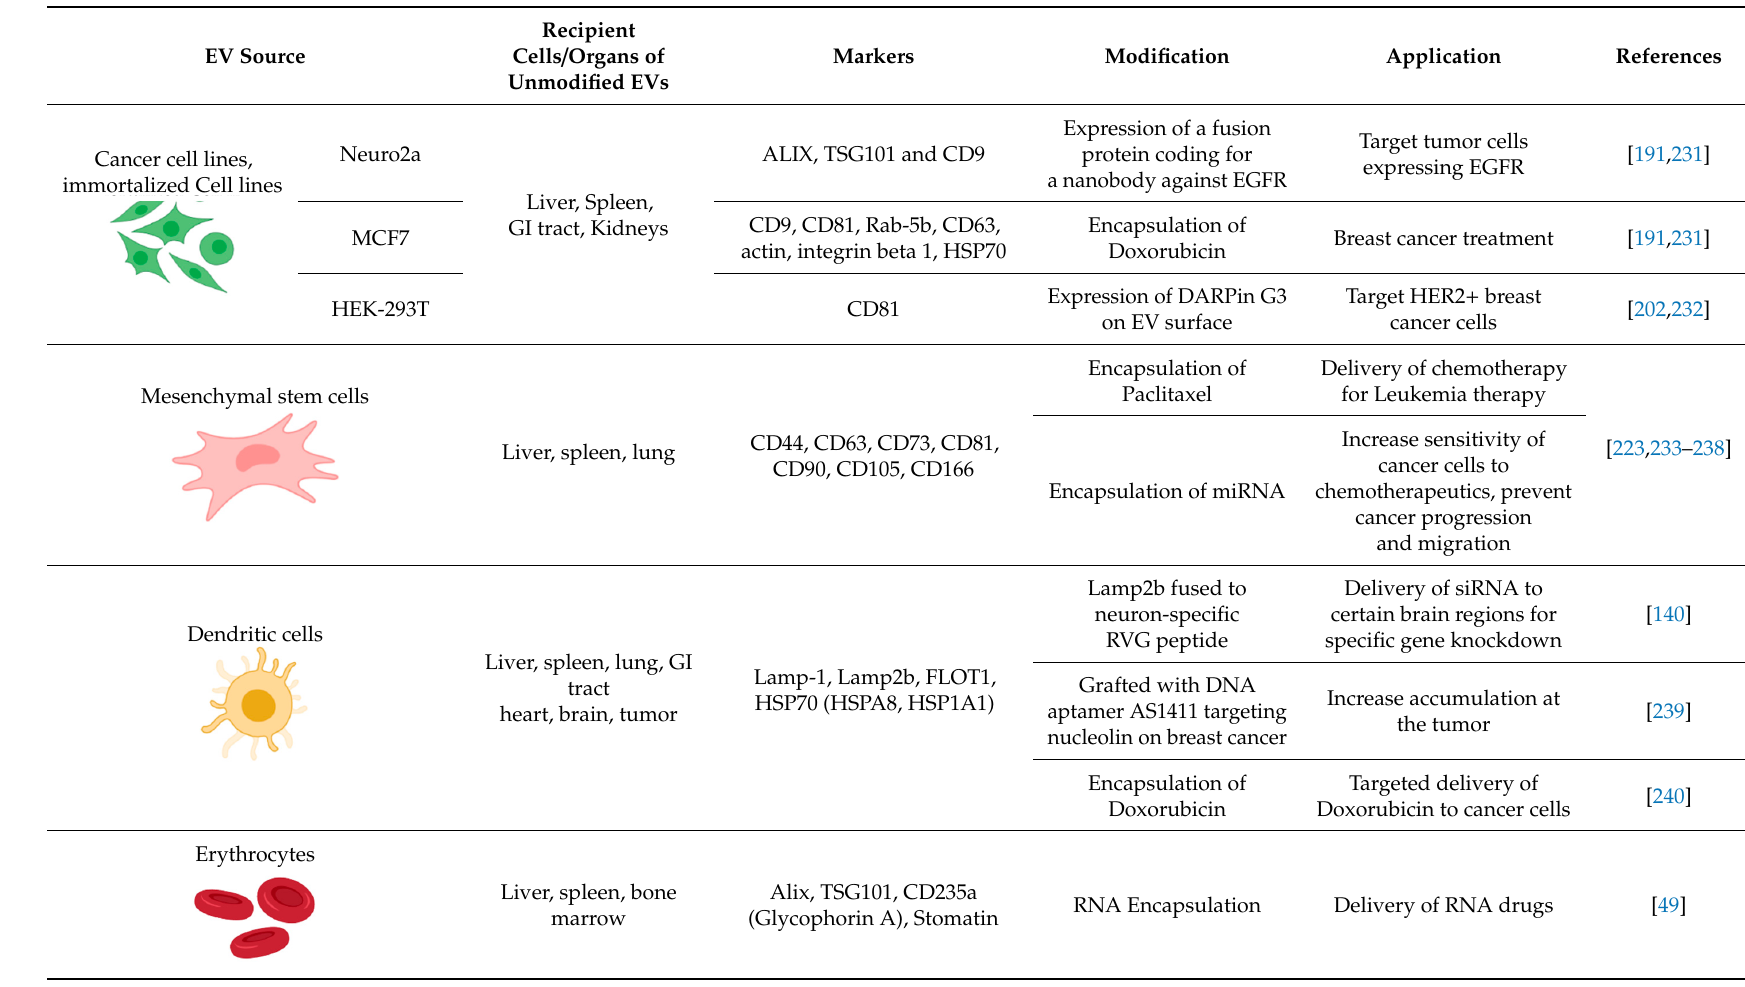
Table 2. An analysis of the di ff erent sources of EVs, their specific markers and therapeutic applications. Images of cells were created with Biorender. Table 2. An analysis of the different sources of EVs, their specific markers and therapeutic applications. Images of cells were created with Biorender. Table 2. An analysis of the different sources of EVs, their specific markers and therapeutic applications. Images of cells were created with Biorender. Table 2. An analysis of the different sources of EVs, their specific markers and therapeutic applications. Images of cells were created with Biorender. Table 2. An analysis of the different sources of EVs, their specific markers and therapeutic applications. Images of cells were created with